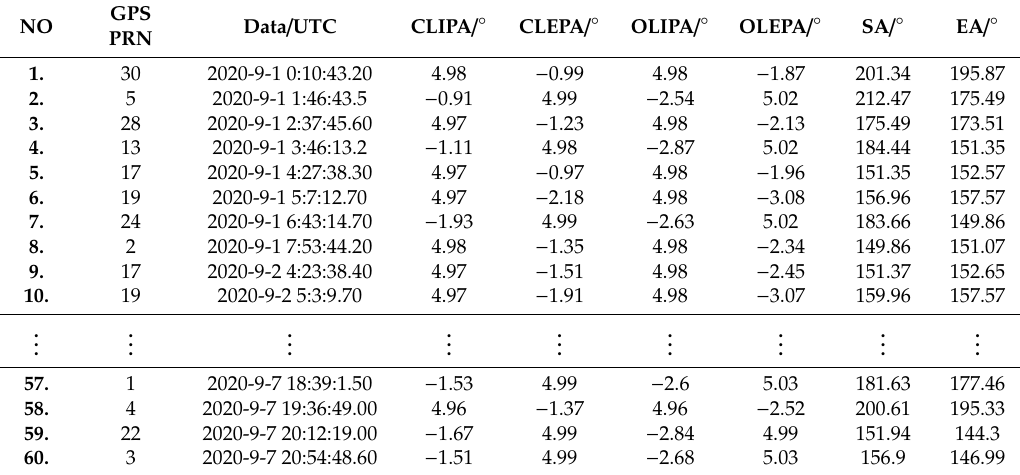
Table 1. List of the closed-loop initial pitch angle (CLIPA), closed-loop end pitch angle (CLEPA), open-loop initial pitch angle (OLIPA), open-loop end pitch angle (OLEPA) and start / end azimuth (SA, EA) from selected occultation